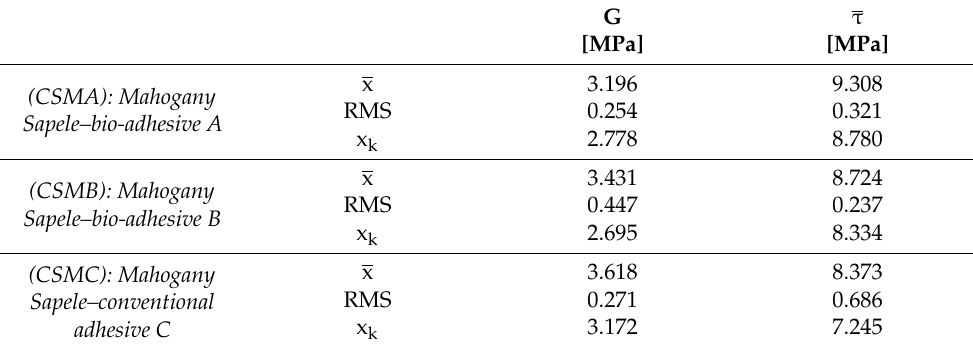
Table 9. Results for Mahogany Sapele shear properties by compression-shear